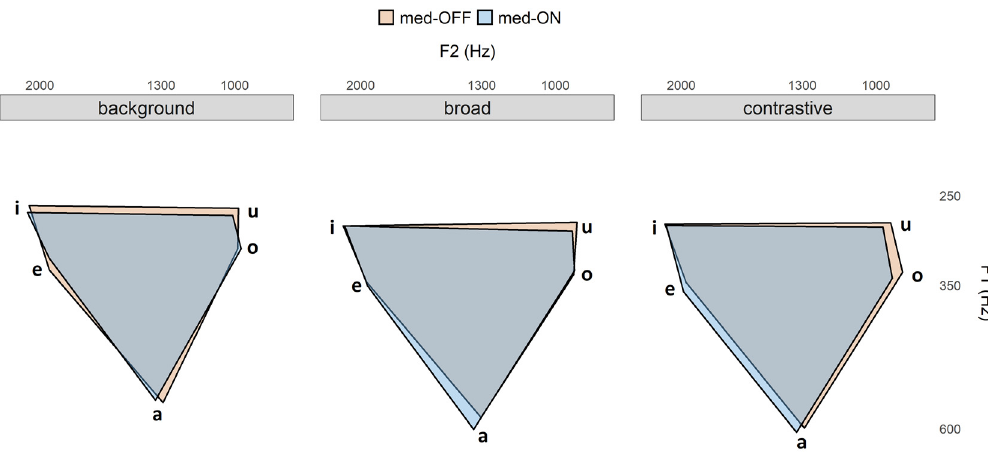
Figure 6. Vowel space area per prominence condition. Medication condition is indicated by color: med-OFF (orange) and med-ON (blue).